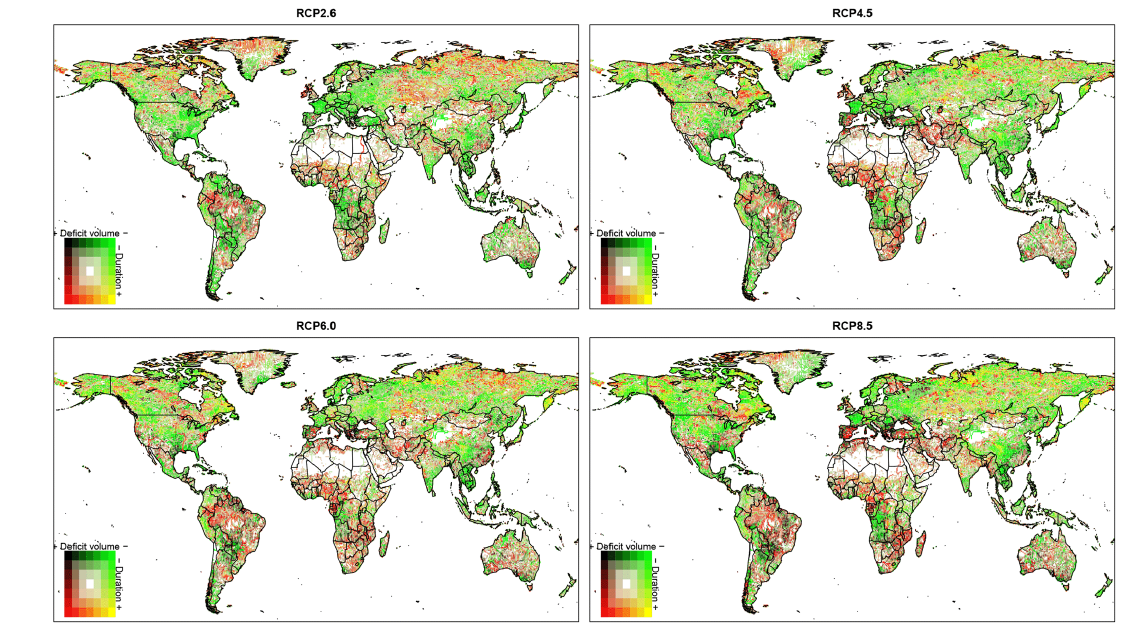
Figure 3. Average trends in drought duration and drought deficit volume, derived with a transient Q 90 threshold from discharge simulation of PCR-GLOBWB. Maps indicate the changes per RCP for an ensemble of five GCMs. Colours indicate the robustness of the trend where the darkest colours are robust (five GCMs agree), thereafter likely (four GCMs agree) and plausible (three GCMs agree). A white colour indicates areas where no drought characteristics were